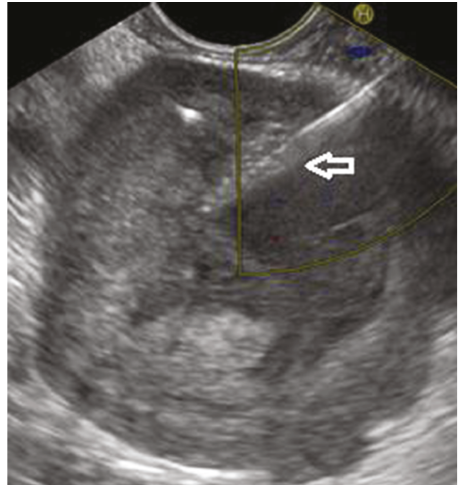
Figure 6: Pancreatic pseudocyst (FNA had been performed before the AXIOS stent was inserted; arrow pointing at the FNA needle).